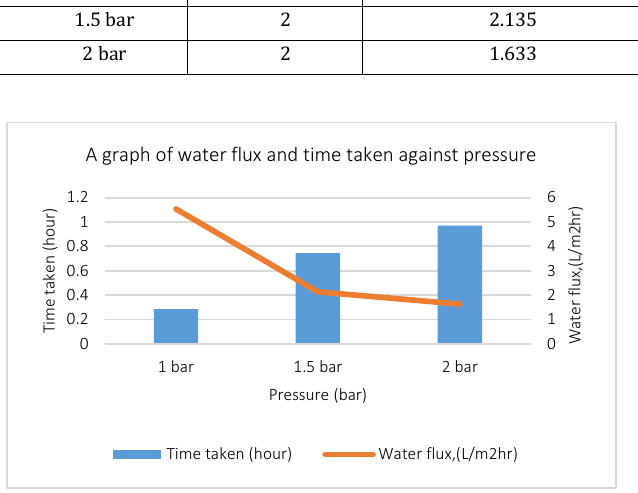
Figure 3: A graph of water flux and time taken against pressure